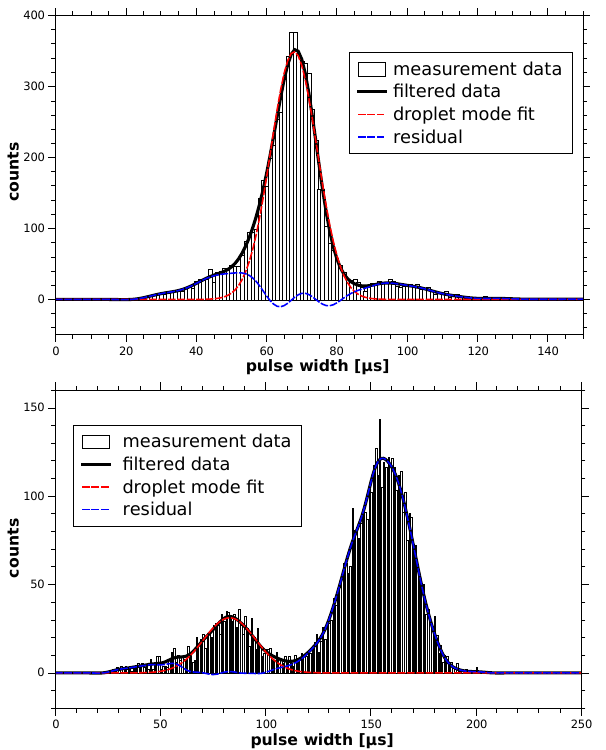
Fig. 9. Illustration of the data evaluation algorithm for two different cases, f ice = 0 . 06 in top panel (example from Fig. 4.1f), f ice = 0 . 82 in bottom panel.